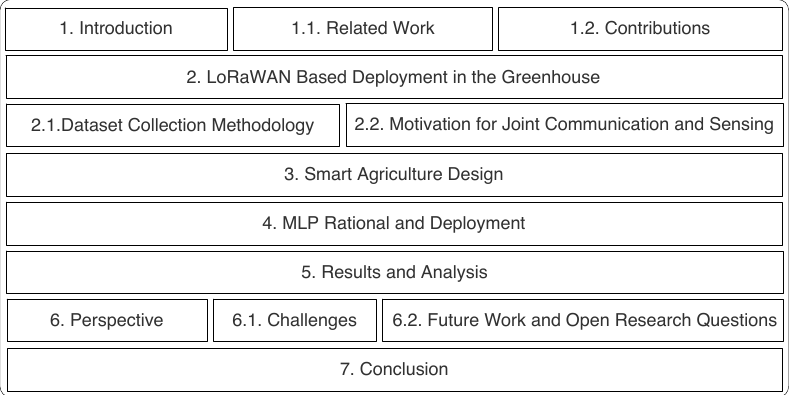
Figure 2. Structure of the paper.